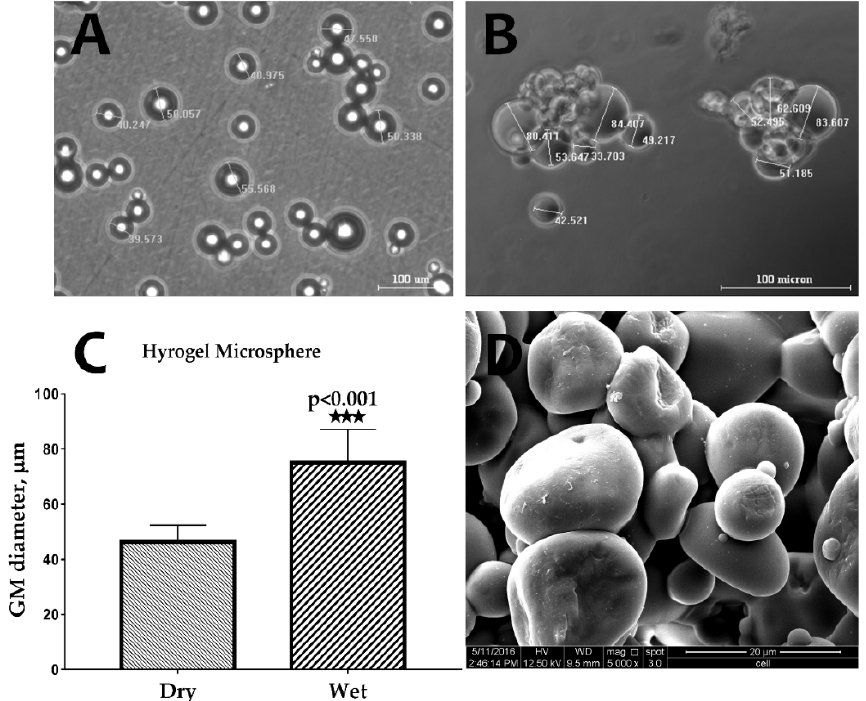
Figure 1. Optical microscope images of gelatin microspheres (GMs) in ( A ) dry and ( B ) wet conditions. ( C ) The swelling measurement of hydrogel microsphere ( n = 6) (*** p < 0.001), and ( D ) an scanning electron microscope (SEM) image of GMs showing the sphericity and smooth surface of the GMs.